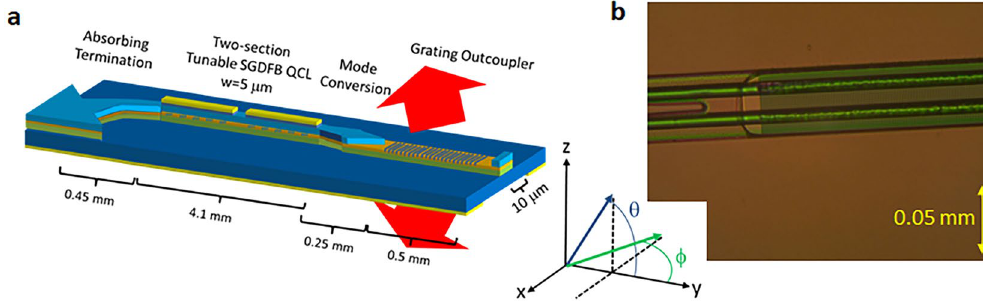
Figure 1. Monolithic mid-infrared beam steering architecture with linear grating. ( a) Schematic of SGDFB laser integrated with linear grating outcoupler. ( b ) Optical microscope image of region connecting waveguide taper to linear grating outcoupler.